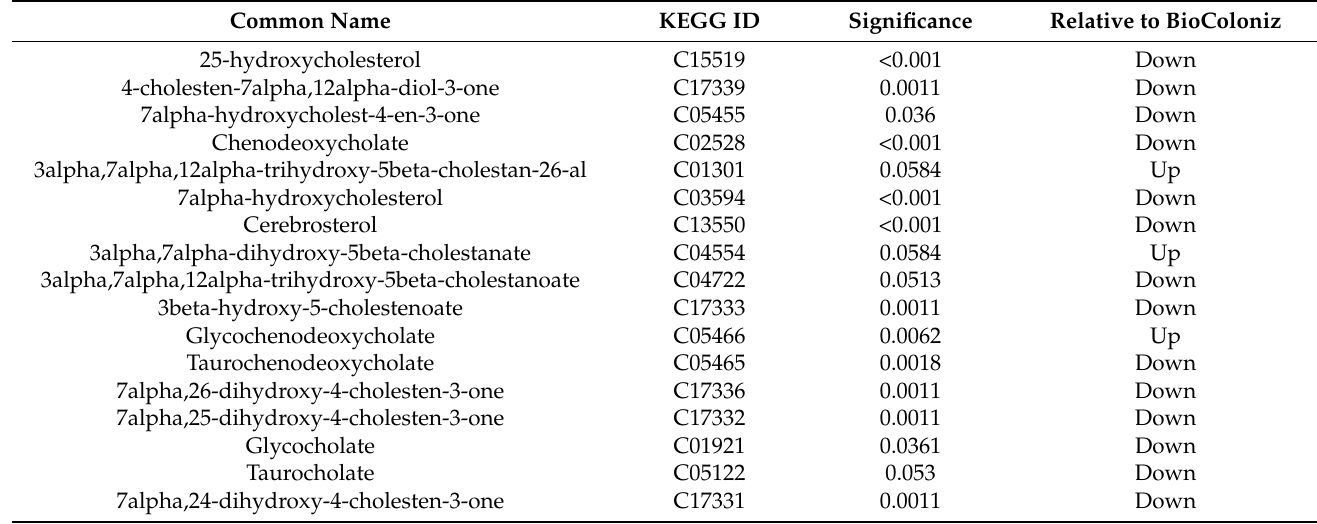
Table 6. Significant features involved in the primary bile acid biosynthesis pathway.